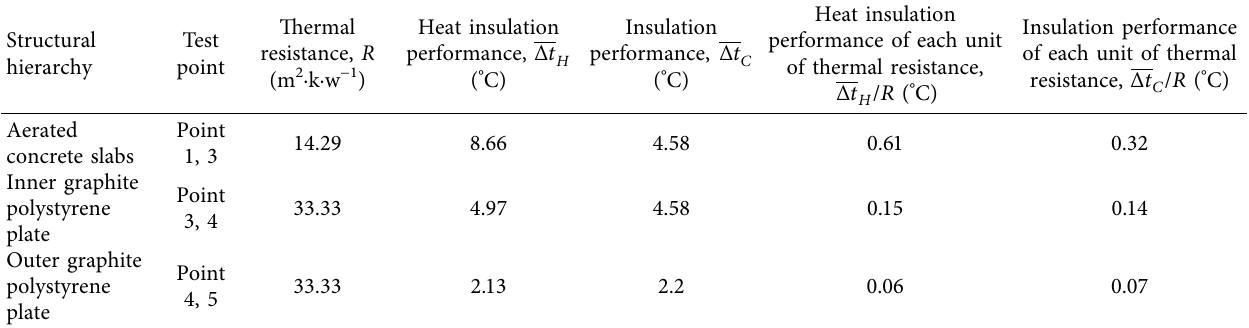
Table 4: Thermal insulation performance of main structural layers of exterior